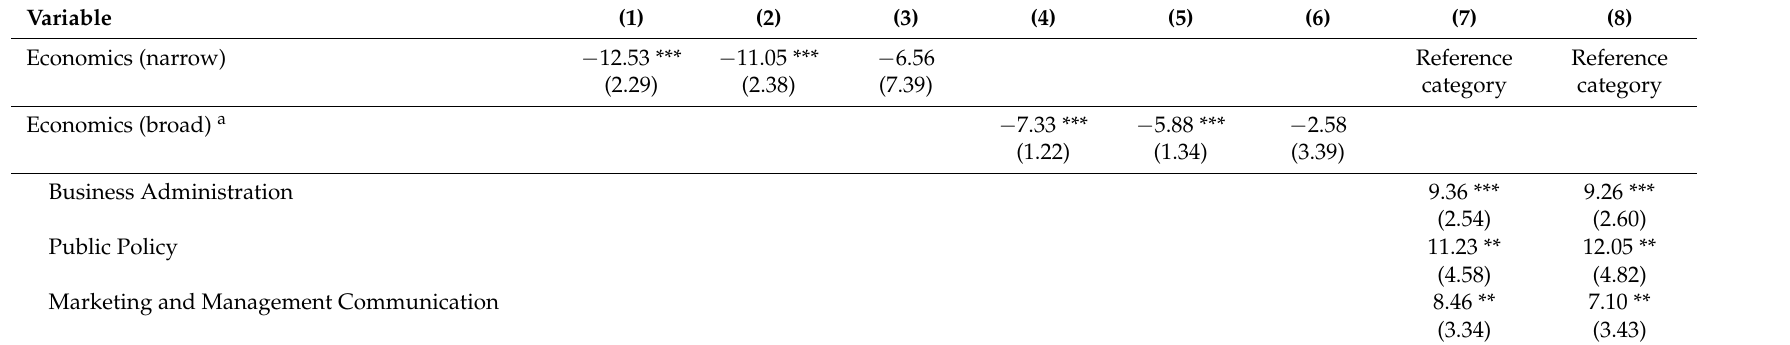
Table 1. Ordinary least squares regressions for giving in the dictator game